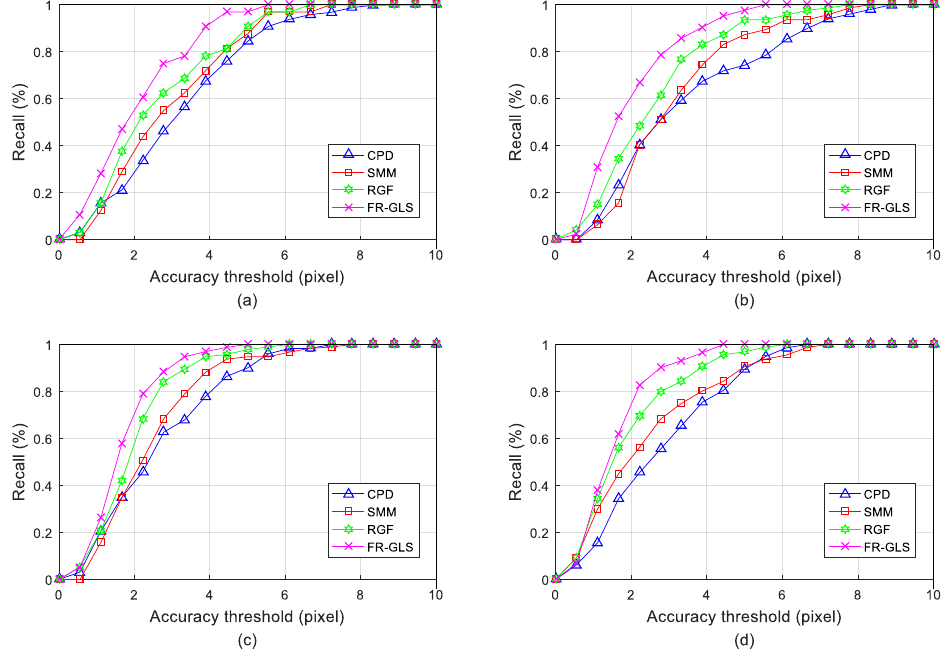
Figure 5. Quantitative comparisons of multispectral face image pairs with four individuals in Figure 4. ( a ) Charles; ( b ) Heo; ( c ) Meng; ( d ) Sharon.